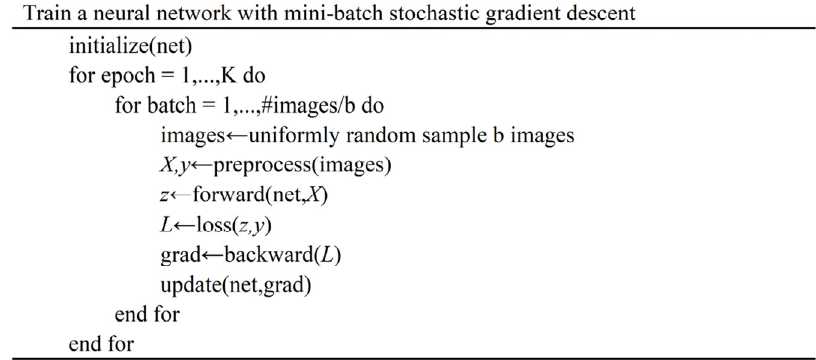
9 of 18 Figure 4. AUV-R physical picture and experimental picture. The dataset of side-scan sonar images is publicly available on the Internet ,includes three kinds of graph-free (human, ship, aircraft), which are composed of 650 training im- ages and 250 test images, and the annotation format is VOC. This dataset has serious sea- bed noise and reverberation interference. Aiming at the problems of complex background and loud noise of sonar images, this paper adds Gaussian noise, salt and pepper noise, and Rayleigh noise to the test sets of two datasets, respectively, to verify that DP-ViT al- gorithm still has good performance in the case of loud noise, which proves that the model has good generalization. In this paper, a small batch gradient descent algorithm is used to optimize the pa- rameters. The small batch gradient descent method is a compromise between the batch gradient descent method and the random gradient descent method. The gradient is used